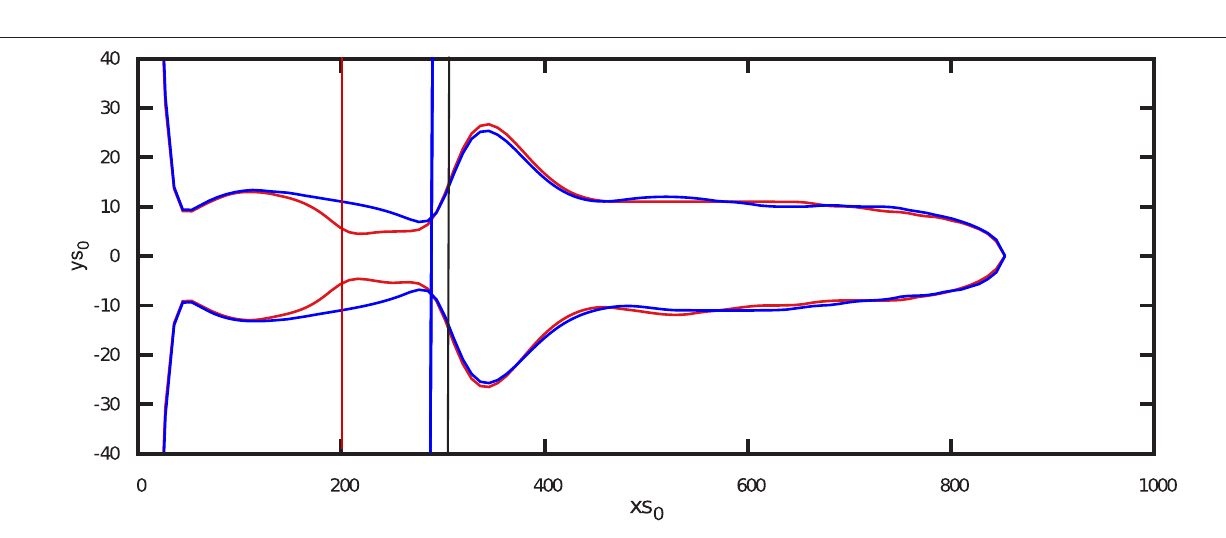
FIGURE 12 | Influence of thickness of the layer on the wormhole shape (Pe = 100 , Da = 0.1 , C = 10 ). The solution pipe in red corresponds to the case where the layer extends from the red vertical line to the black vertical line. The solution pipe in blue corresponds to the case where the layer extends from the blue line to the black line. Note that the aspect ratio of the plot has been altered to better visualize